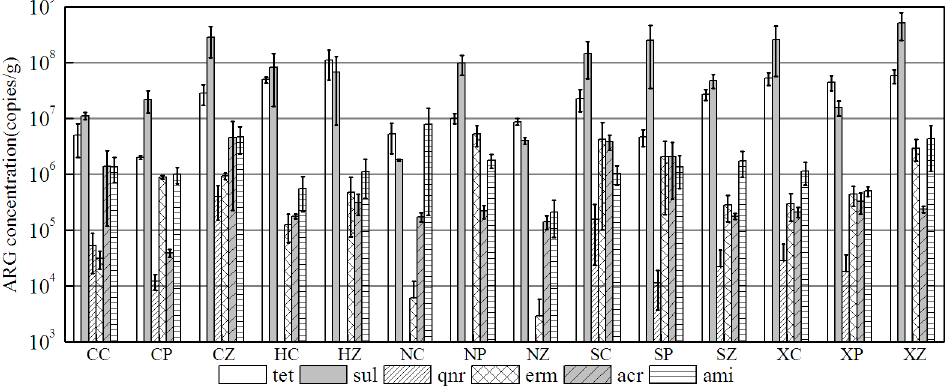
Fig 5. Abundance of 6 classes of ARGs in manured soils of different livestock farms. (First letter: C-CZ, H-HA, N-NJ, S-SQ, X-XZ; Second letter: Z-porcine manure; P-poultry manure; C-cattle manure. tet : tetA